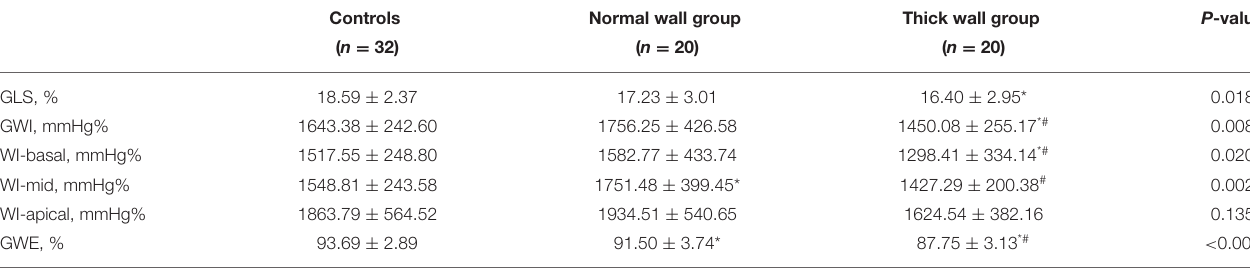
TABLE 3 | Longitudinal strain and myocardial work index of the study population.